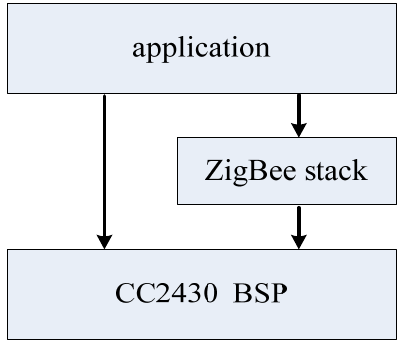
Figure 14. ZigBee module software level